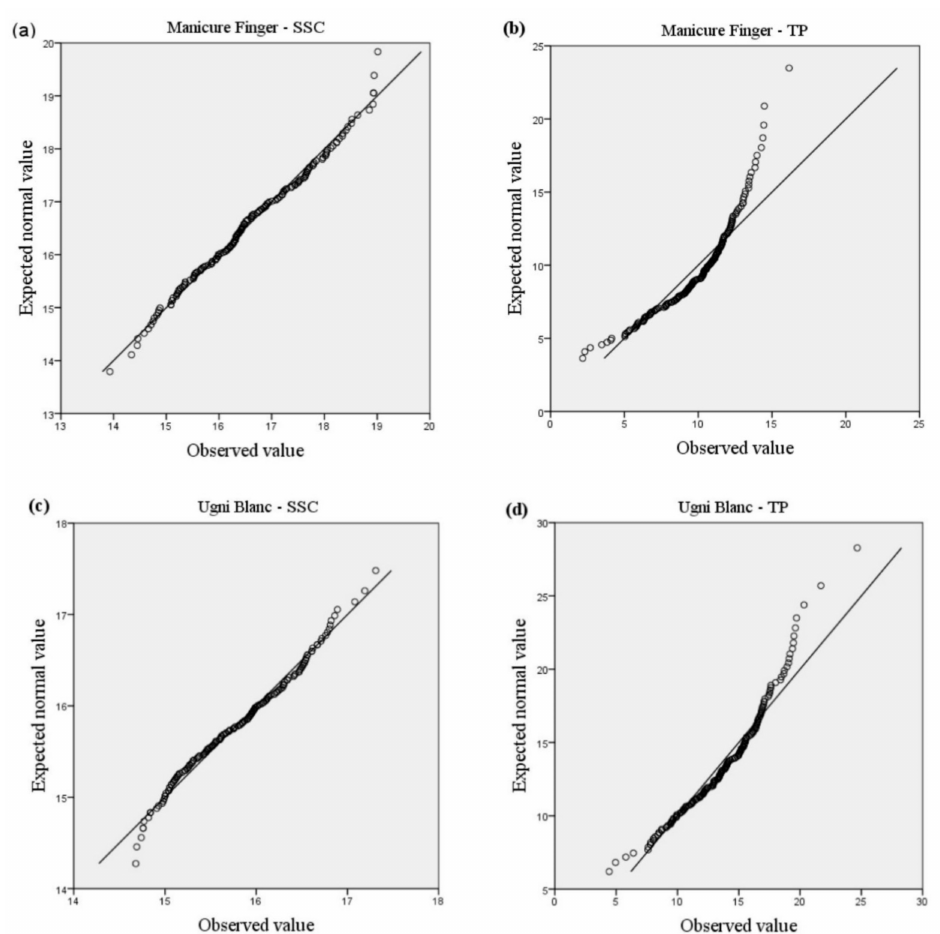
Figure 1. Normal probability plots for the distributions of total soluble solid content and total phenolic compounds in two grape varieties. SSC: soluble solid content; TP: total phenolic compounds. ( a ) expected and observed values of SSC in Manicure Finger; ( b ) expected and observed values of TP in Manicure Finger; ( c ) expected and observed values of SSC in Ugni Blanc; ( d ) expected and observed values of TP in Ugni